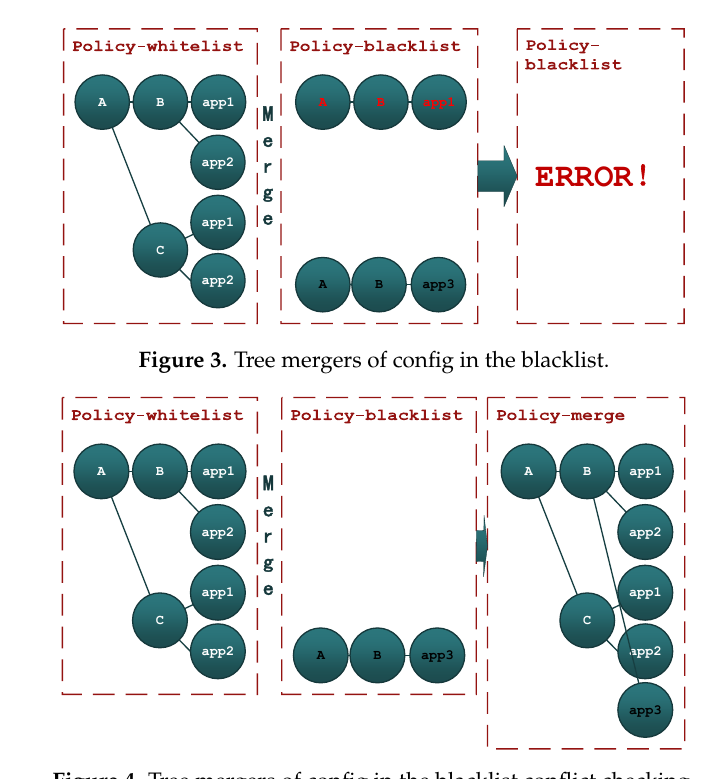
Figure 4. Tree mergers of config in the blacklist conflict checking.